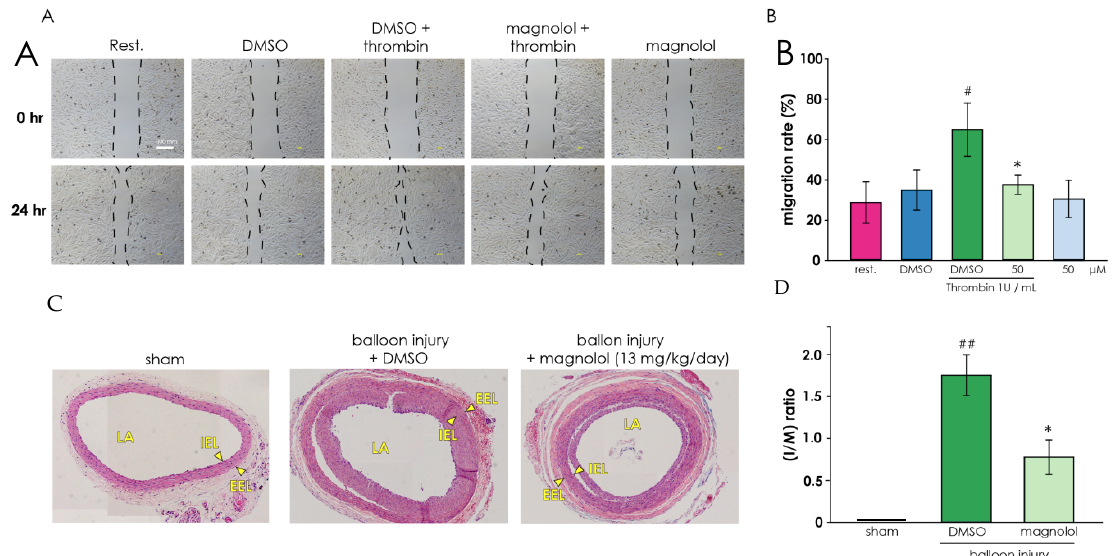
Figure 5. Magnolol inhibits the migratory potential of A10 cells and mitigates restenosis. ( A ) The effect of magnolol treatment on the migratory potential of A10 cells was analyzed through the wound healing assay. Representative photomicrographs of initial and final wounds were shown at 40 × magnification and representative examples of three similar experiments. ( B ) Cell migration rate data were presented as the means ± SD of the means (n = 3). # p < 0.05, compared with the DMSO alone group; * p < 0.05, compared with the DMSO plus thrombin treated group. ( C ) Effects of magnolol on balloon angioplasty-induced neointimal formation in rat common carotid artery. Each experiment group (sham operation group, solvent control group (DMSO), and magnolol (13 mg/kg/day) treated group) were taken microscopic images 14 days after balloon angioplasty. The compiled statistics are shown in ( D ). Data are expressed as mean ± standard deviation ( n = 3). ## p < 0.01, compared with the sham group; * p < 0.05, compared to the solvent (DMSO) group. LA, lumen area; IEL, internal elastic lamina; EEL, external elastic lamina.